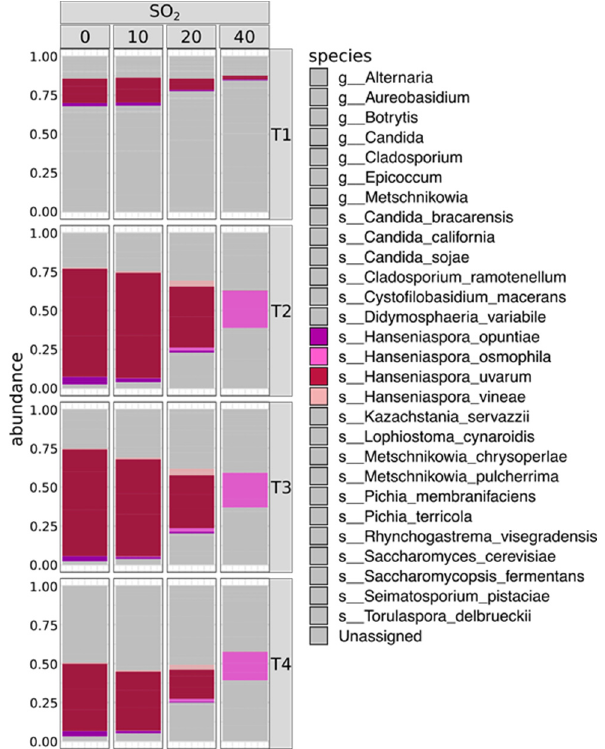
Figure 4. Species-level metabarcoding analysis of community response to the SO 2 addition. Vintage 2019 Chardonnay juice was treated with increasing concentrations of total SO 2 (mg / L). Ferment samples were taken at four timepoints (T1, at crush; T2, 10% sugar utilization; T3, 50% sugar utilization; T4, 90% sugar utilization) and subjected to ITS metabarcoding. Only species that exceeded 0.1% abundance in at least one sample are shown. For those OTU where a species-level designation was not possible, the genus-level taxonomic classification of the OTU was used. Only members of the genus Hanseniaspora are colored.